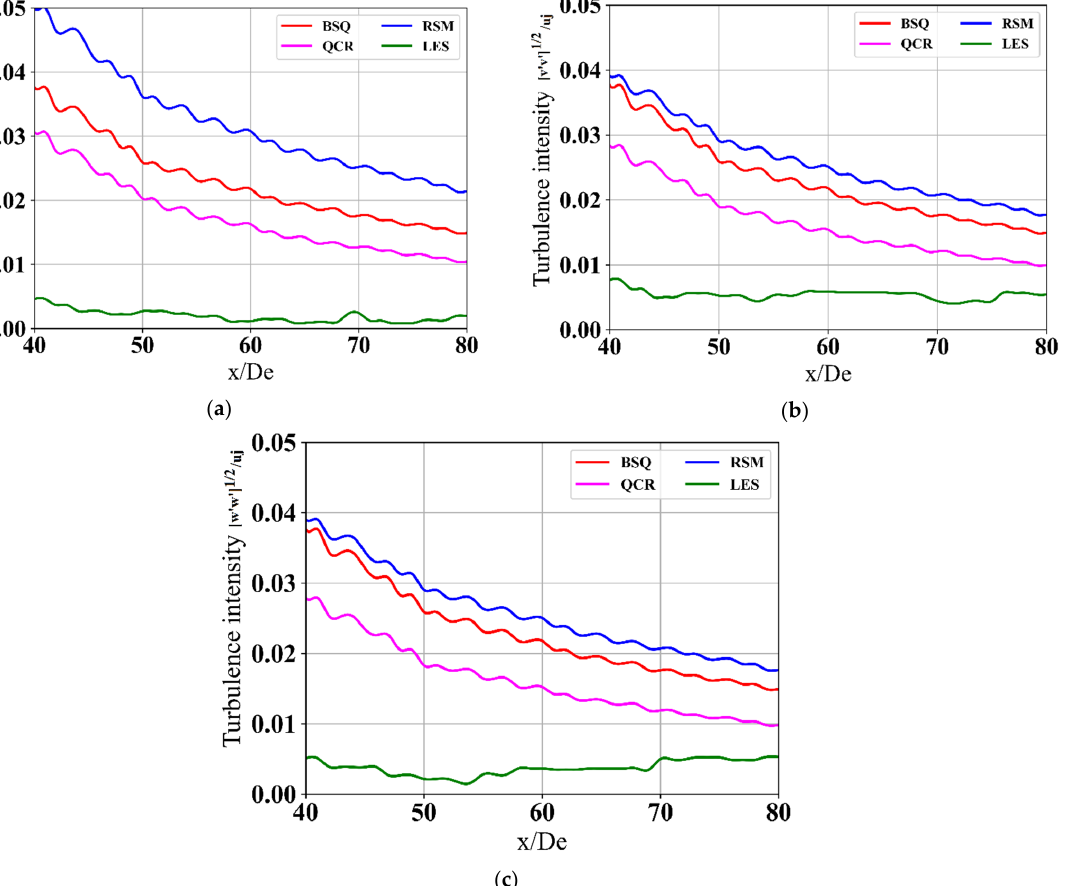
Figure 20 . Centerline profiles of turbulence intensities, ( a ) streamwise, ( b ) radial, ( c ) spanwise.